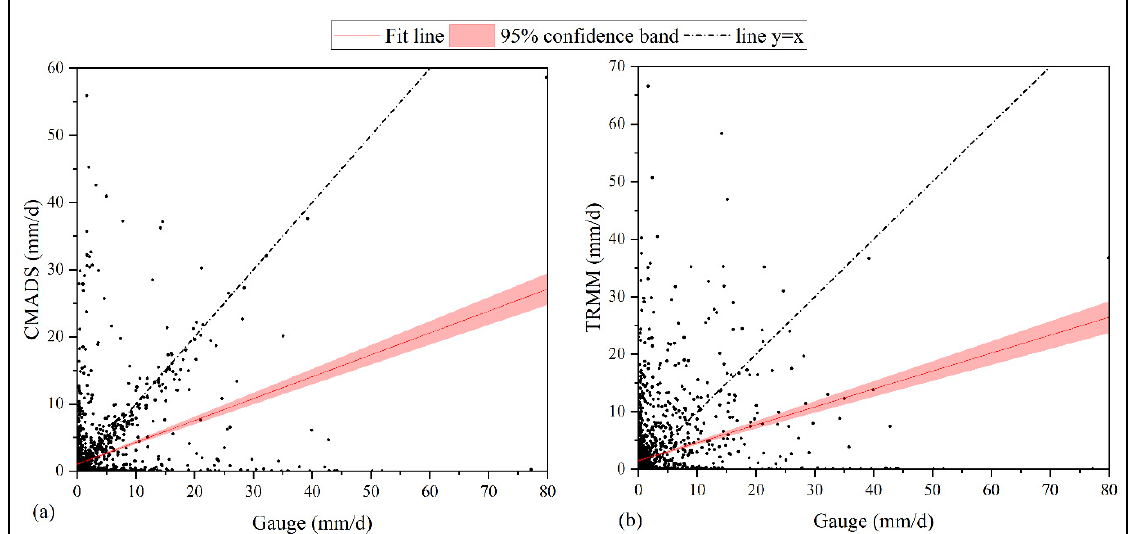
Figure 3. The box diagrams of three precipitation records at a monthly scale in the DRB.